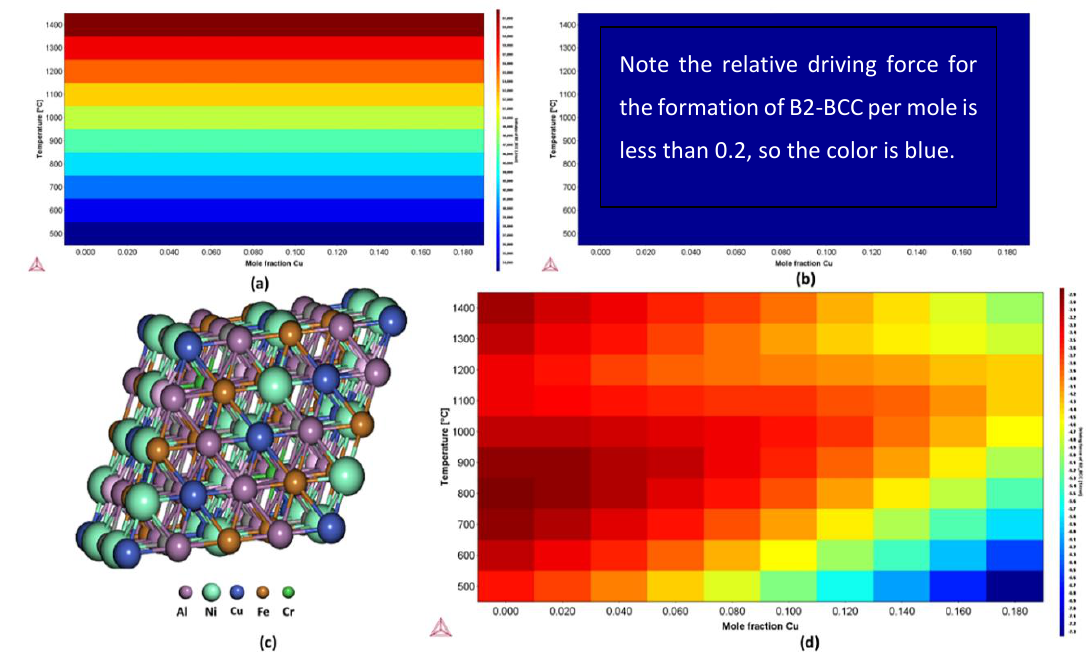
Figure A5. Role of Cu on the thermodynamic stability of HEA AlCuCrFeNi ( a ) Total enthalpy of mixing (J/mole) ( b ) Entropy of mixing (J/mole/K) ( c ) Optimized BCC lattice ( d ) Driving force for formation of B2_BCC per mole.